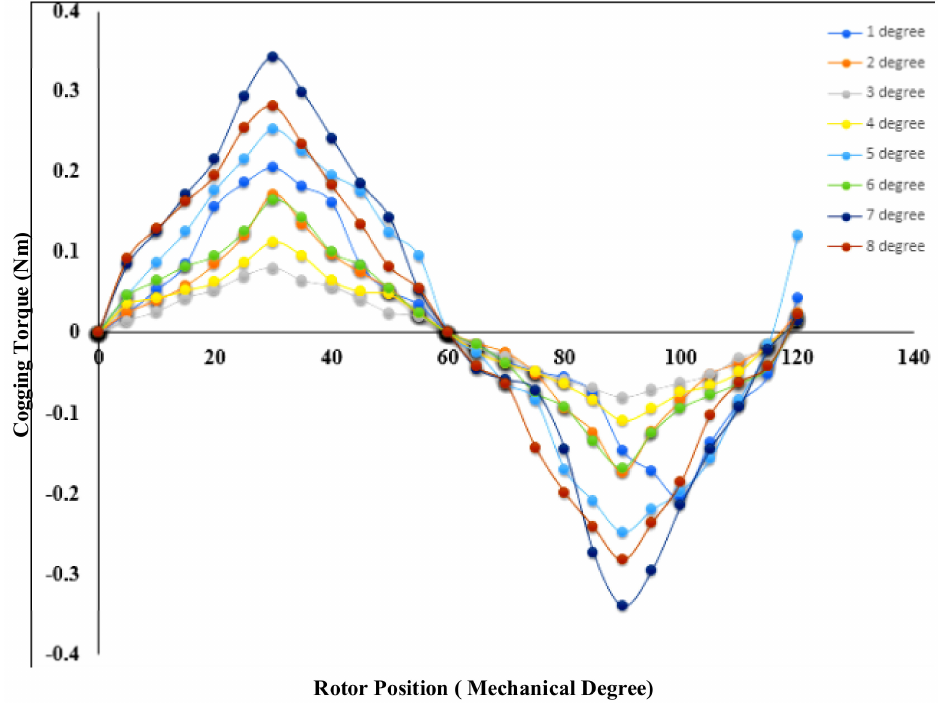
Figure 8. FEA results of cogging torque with varying shifting angle.